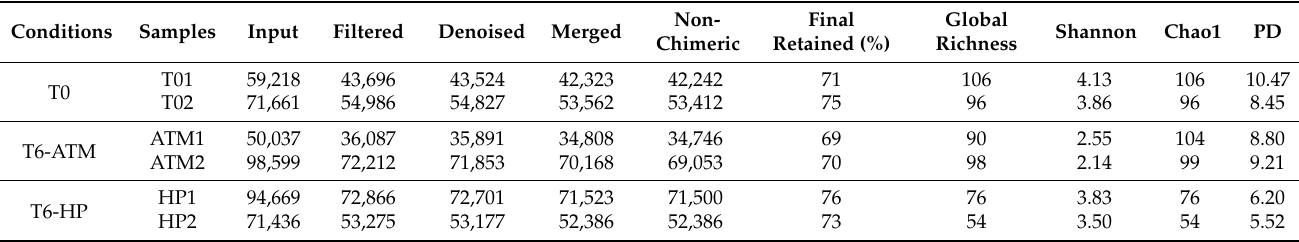
Table 2. Data quality trimming and alpha diversity indices. The columns headings of Table 2 indicate the number of reads retained after each processing step of DADA2 from the initial raw data (Input). “Filtered” column corresponds to the removal of bad quality reads, “Denoised” corresponds to the correction of sequencing errors, “Merged” are assembled reads and “Non chimeric” are not artefact sequences. The “Final retained” column is the read proportion conserved for downstream analyses. The “global richness” (which corresponds to the number of observed amplicon sequence variants—ASVs), Shannon, Chao1, and PD (phylogenetic diversity) columns provide alpha diversity indices calculated for each